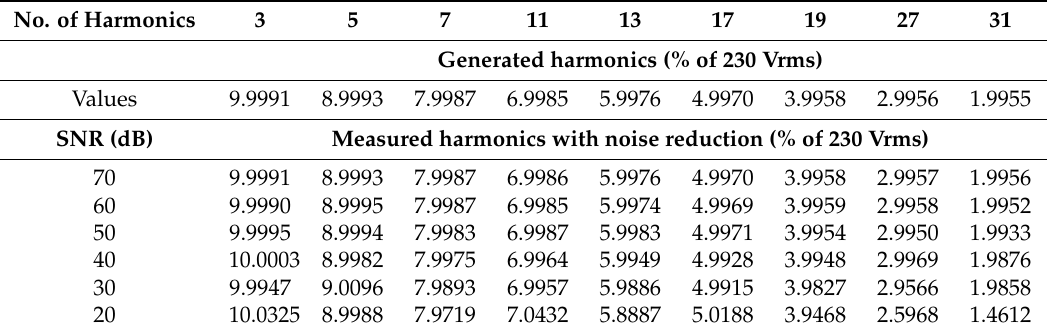
Table 1. Values of generated and measured signal harmonic as % of signal amplitude.